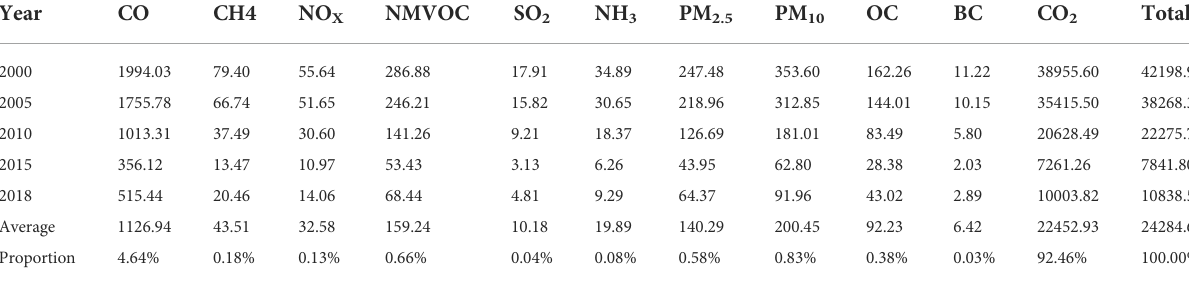
TABLE 4 Estimated annual emission of various pollutants from the study area between 2000 and 2018 (Unit: Gg).